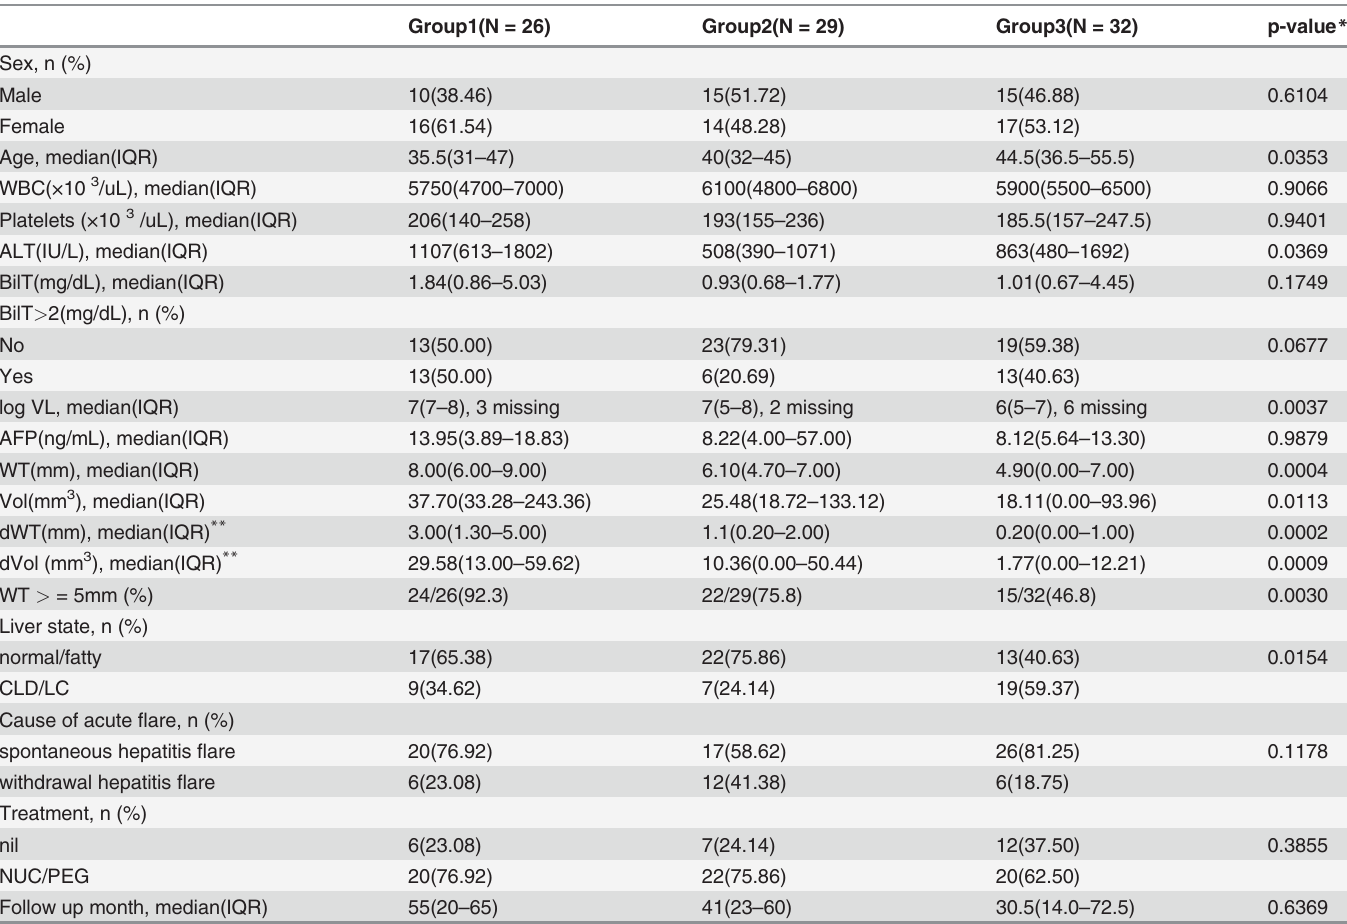
Table 1. The distributions of baseline characteristics and variable factors during acute fl are including the results of nodal width and volume for 3